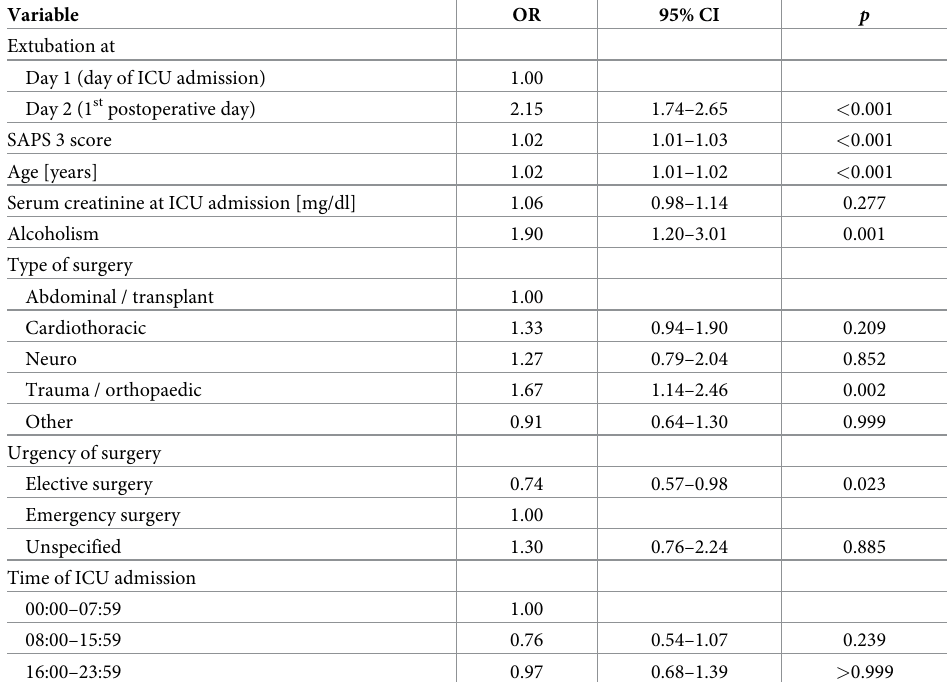
Table 3. Multivariate logistic regression analysis for agitation (SAS > 5) or over-sedation (SAS < 3) during ICU stay after extubation as the dependent variable and variables of interest and adjustment as co-variates. The model includes anonymous ICU identifiers as fixed effects, these are not depicted.